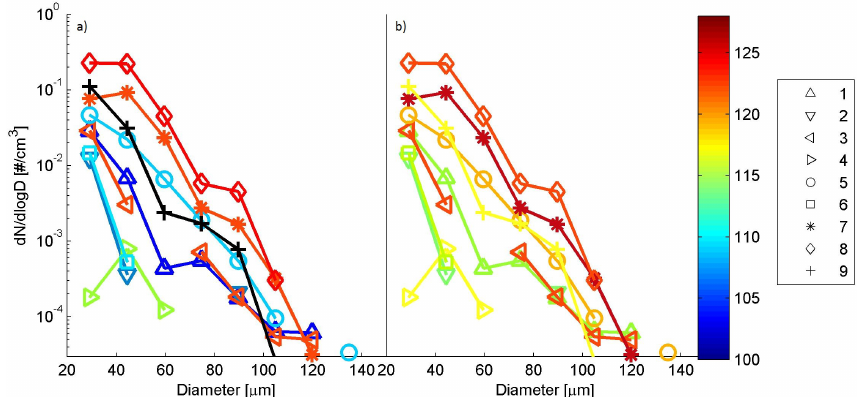
Fig. 4. Detail of Fig. 3 showing ice crystal size distribution (SD) recorded by the CIP-GS during contrail passes 1–9 in Flight B587. (a) SD coloured to ambient RH value when contrail was formed, (b) SD coloured to ambient RH value when contrail was sampled. Legend is given in the figure title, and lines are colours to the RH ice (%) scale shown on the right.